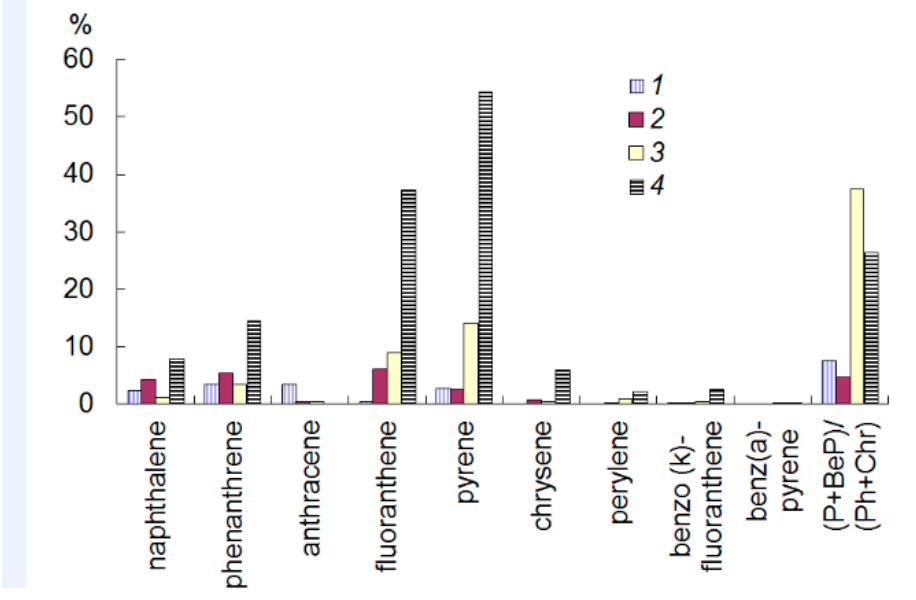
Figure 5. The content of PAHs in SPM and molecular markers in the snow-ice cover at the station in the mouth of Severnaya Dvina (March 2007): 1 —snow, 2 —ice top, 3 —ice bottom, 4 —near the coast of the Mud’yug Island (whole ice core).